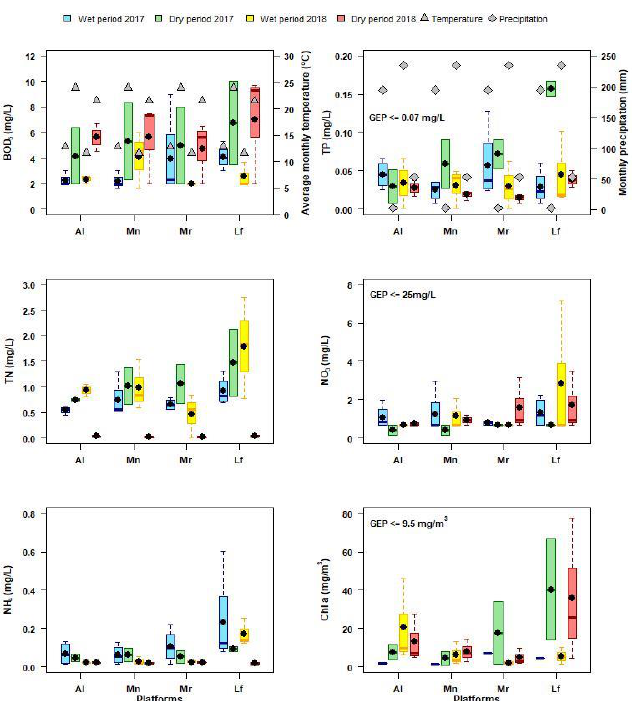
Figure 8. Spatial and temporal variation of the organic descriptors, nutrients, and Chl-a in the water samples during the period of the study. The black circles indicated the mean, the line across the box represents the median, and the bottom and top of the box show the standard error. Recommended guide levels for the good ecological potential (GEP) are indicated in the plot